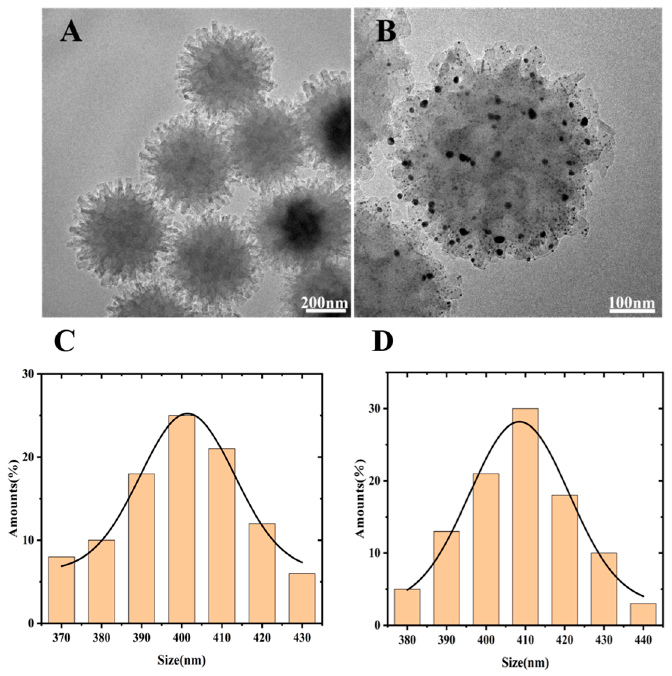
Figure 3. TEM images of COF nanomaterials ( A ) and AuNPs@COF nanocomposites ( B ); COF nanomaterials ( C ); and AuNPs@COFs nanocomposites’ ( D ) particle diameter distribution.